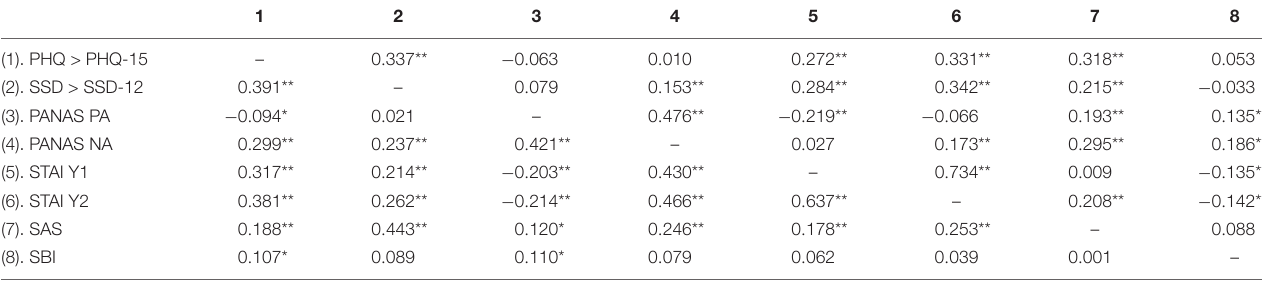
TABLE 3 | Correlations among related variables for each cultural group. 1 2